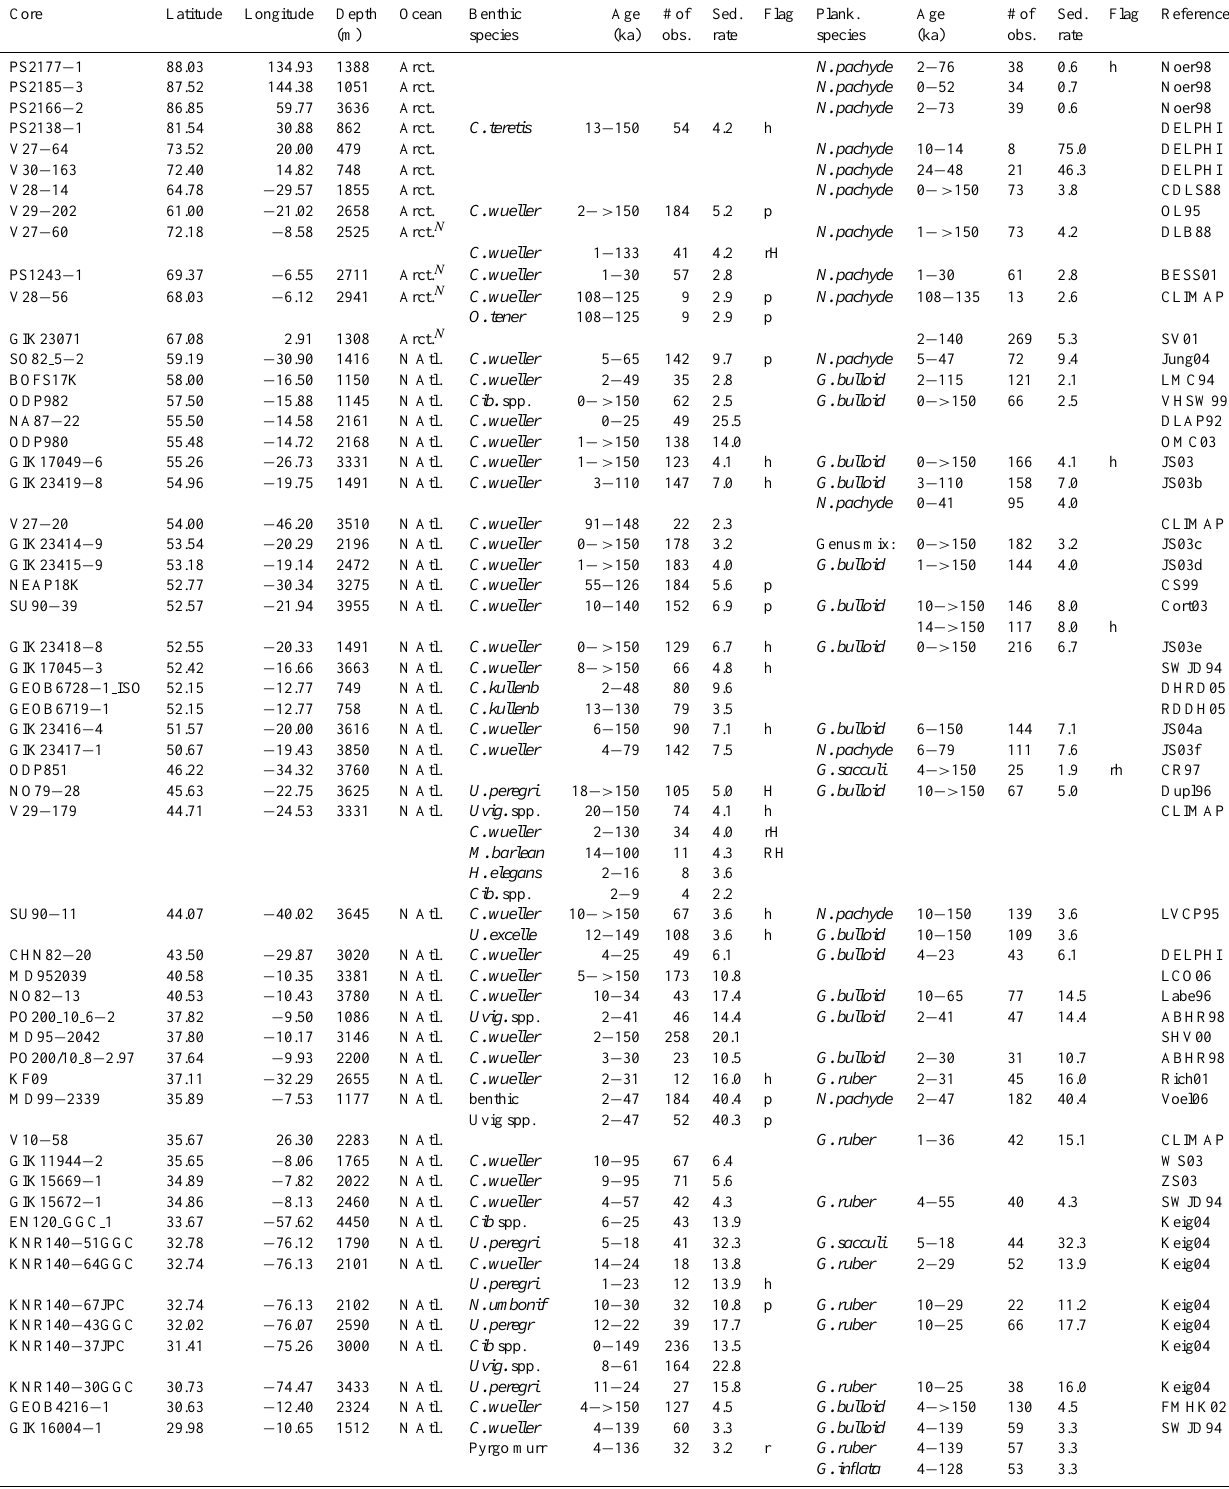
Table 1. Cores used in the data synthesis. Flags: R=mean data resolution poorer than 6ka; r=mean data resolution poorer than 3ka; H=at least one period of > 20ka with no obseravtions; h=at least one period of > 10ka with no observations; p=upwelling region or phytodetritus effect suspected; X=no processed data from